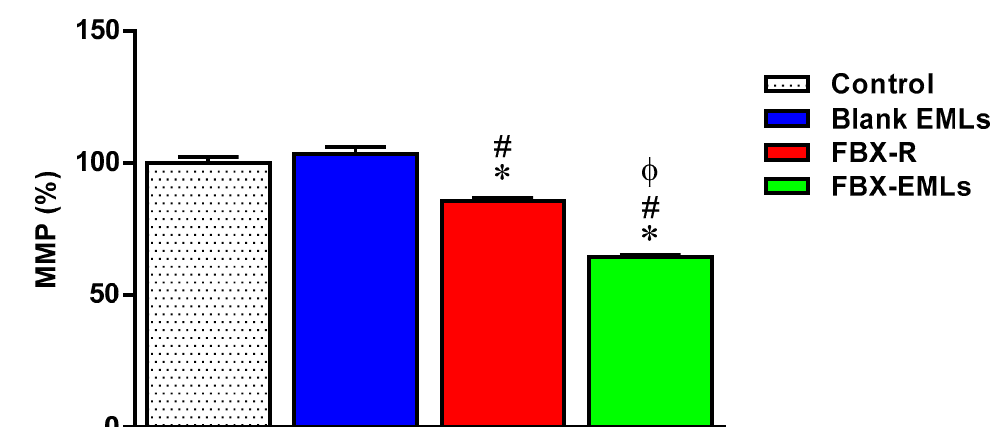
Figure 8. Impact of the treatment with Blank EMLs, FBX-R, or optimized FBX-EMLs on the variation of the MMP (%) of HCT 116 cells. Values were normalized with respect to control untreated HCT 116 cells and are expressed as the percent (%) variation of MMP. Data are the mean of 4 independent experiments ± SD. * Significantly different vs. Control (p < 0.05); # Significantly different vs. Blank EMLs ( p < 0.05); Φ Significantly different vs. FBX-R ( p < 0.05).